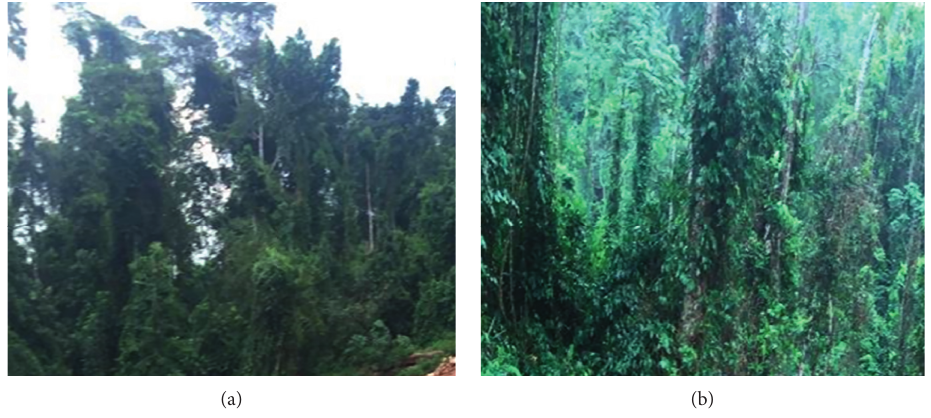
Figure 4: Remnant portions of the Fure River Forest Reserve GSBA adjoining the prospecting area.